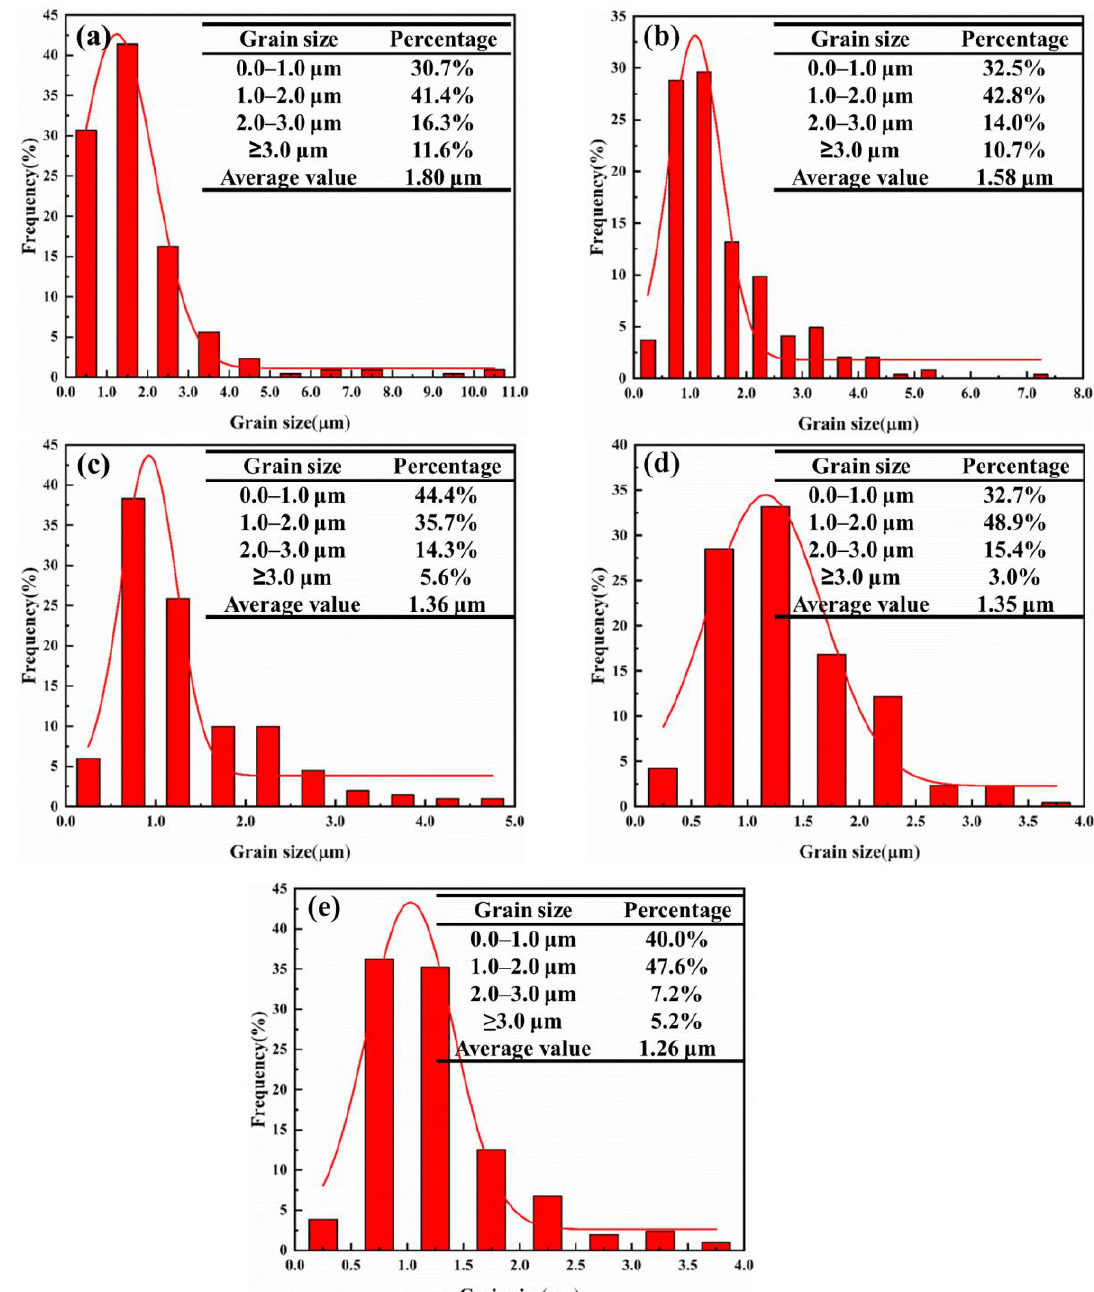
Figure 4. Grain size distribution of the cermets with different SiC p content: ( a ) 0.0 wt.%; ( b ) 1.0 wt.%; ( c ) 2.0 wt.%; ( d ) 2.5 wt.%; ( e ) 3.0 wt.%.